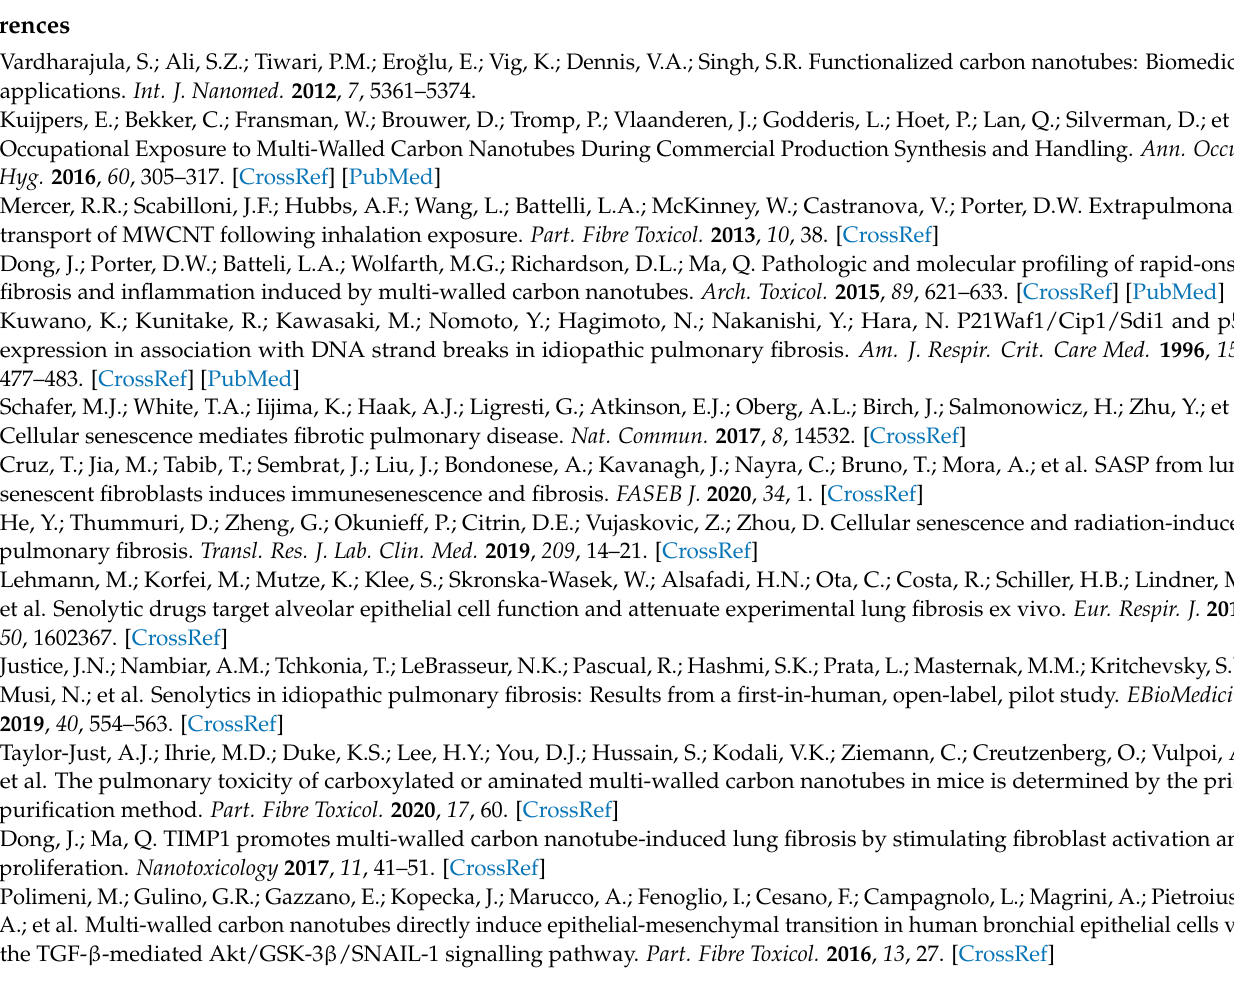
Figure A2. Full unedited gel for Figure 3